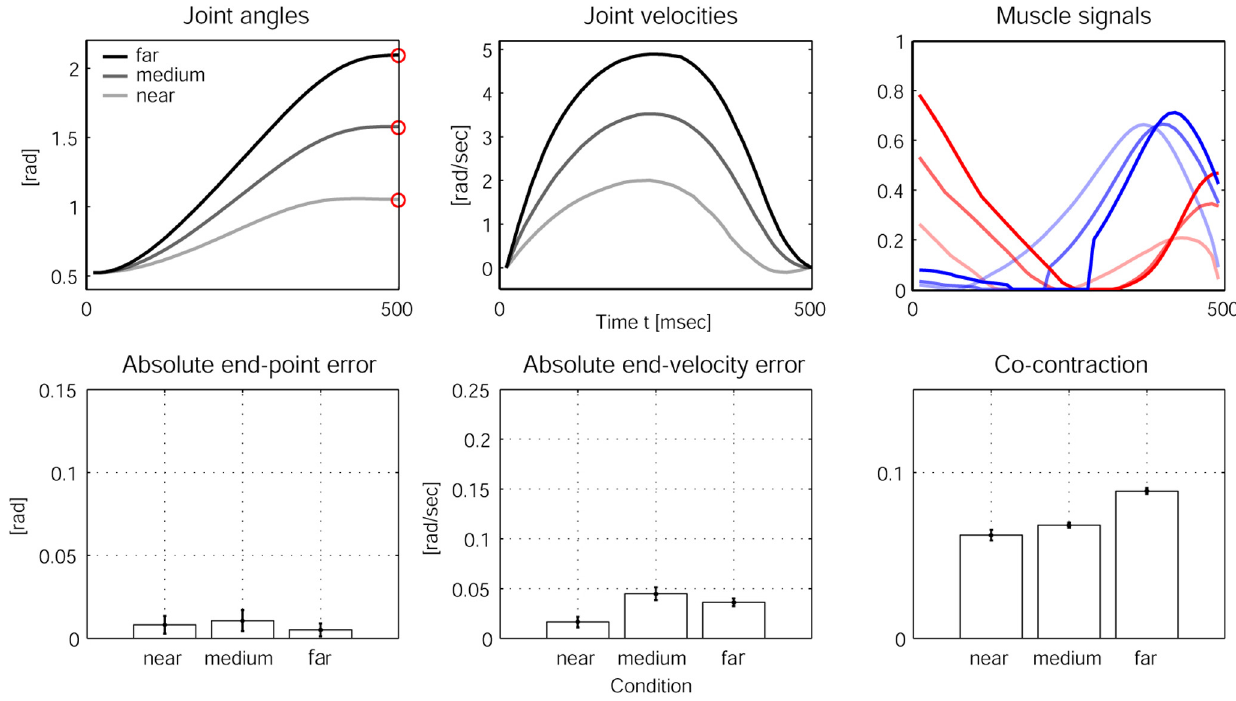
Figure 5. Experimental results from stochastic OFC-LD for different peak joint velocities. The first row of plots shows the averaged joint angles (left), the averaged joint velocities (middle) and the averaged muscle signals (right) over 20 trials for reaches towards the three target conditions ‘‘near’’, ‘‘medium’’ and ‘‘far’’. The darkest line indicates ‘‘far’’, the brightest indicates the ‘‘near’’ condition. The bar plots in the second row quantify the reaching performance averaged over 20 trials for each condition. The end-point errors (left) and end-velocity errors (middle) show good performance but no significant differences between the conditions, while co-contraction during the motion as expected increases with higher velocities, due to the higher levels of muscle signals.